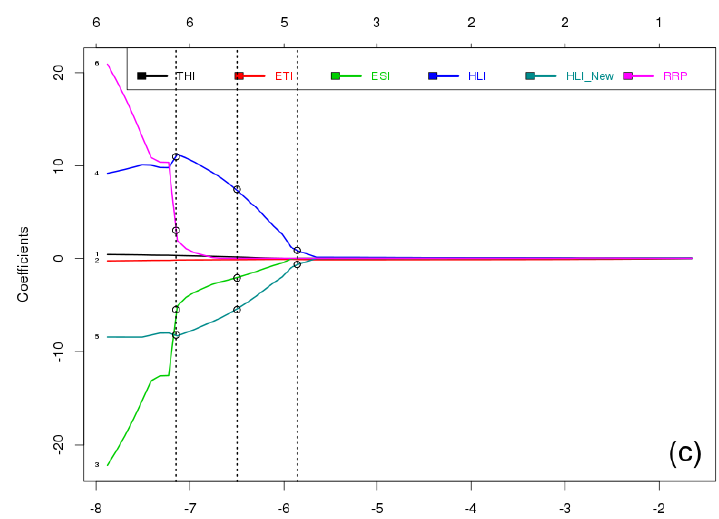
Figure 5. LASSO analysis to find the best linear model between climate indices and milk yield ( a ), fat ( b ), and protein ( c ) from 2002 to 2010 in summer. On the bottom X axis, the shrinkage regularization factor is given in logarithmic units (log λ ). The number on top of the figure indicates the number of Lasso selected predictors at the log λ value.